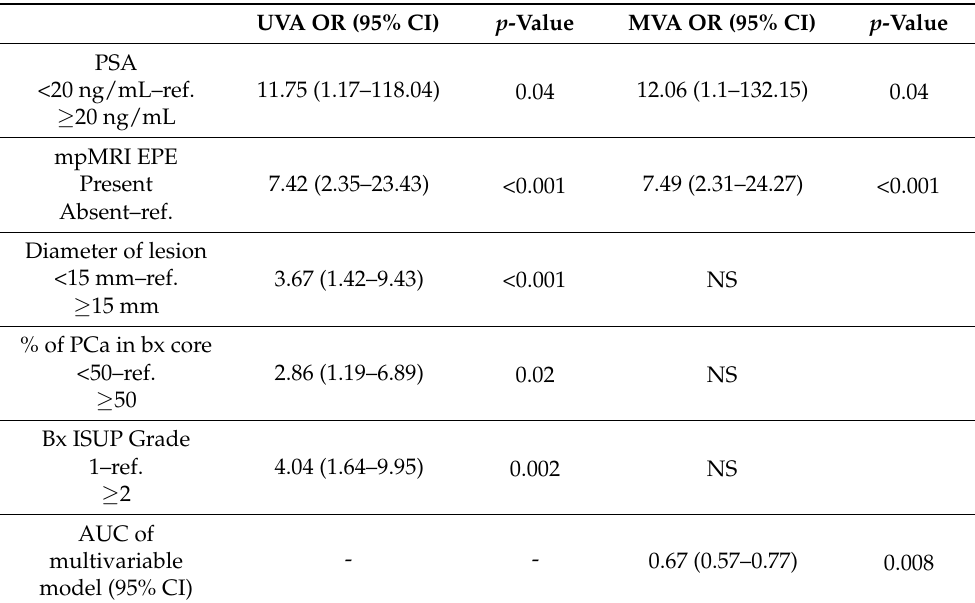
Table 3. Univariate and multivariate logistic regression analyses predicting EPE for each side of the